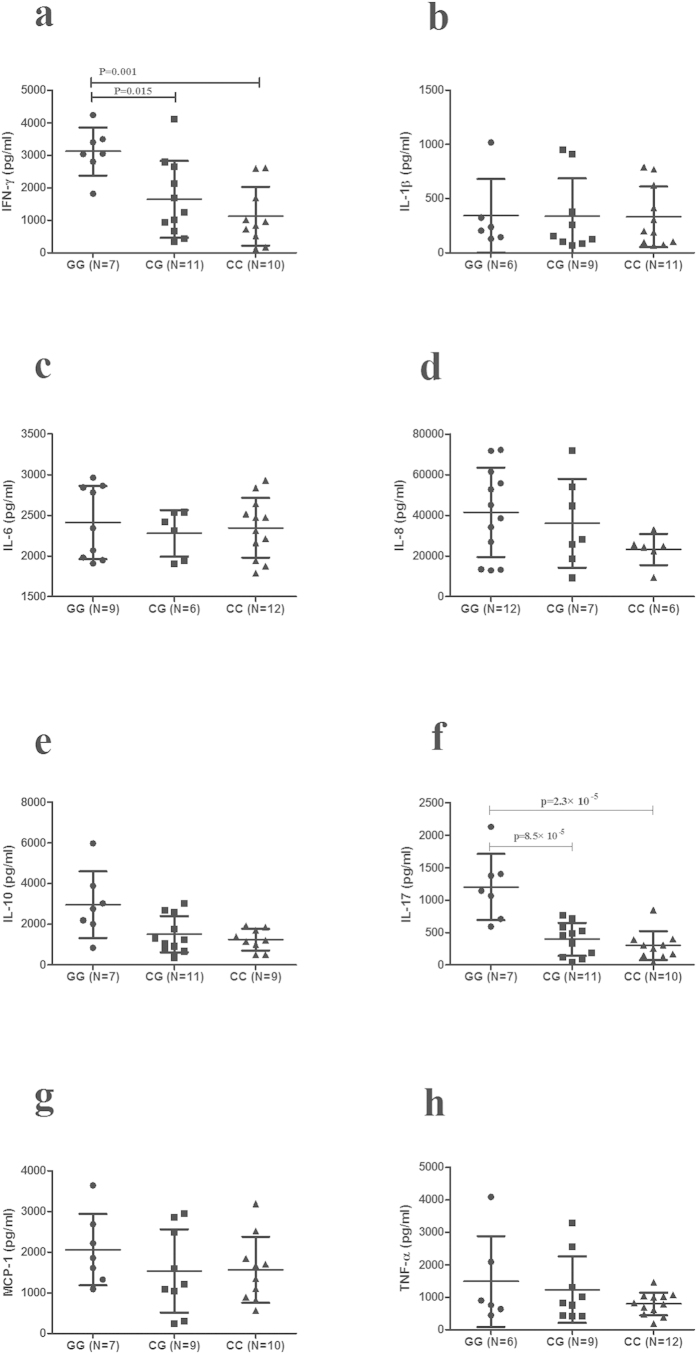
The influence of C3 rs408290 on cytokines production.Different genotypes of C3 rs408290 on cytokine production. The levels of IFN-γ (a), IL-1β (b), IL-6 (c), IL-8 (d), IL-10 (e), IL-17 (f), MCP-1 (g), and TNF-α (h), in PBMCs from normal controls with different genotypes (GG: n = 6–12, CG: n = 6–11, CC: n = 6–12). Significance was tested by two independent samples Nonparametric test or one-way ANOVA test. Data are shown as mean ± SD.